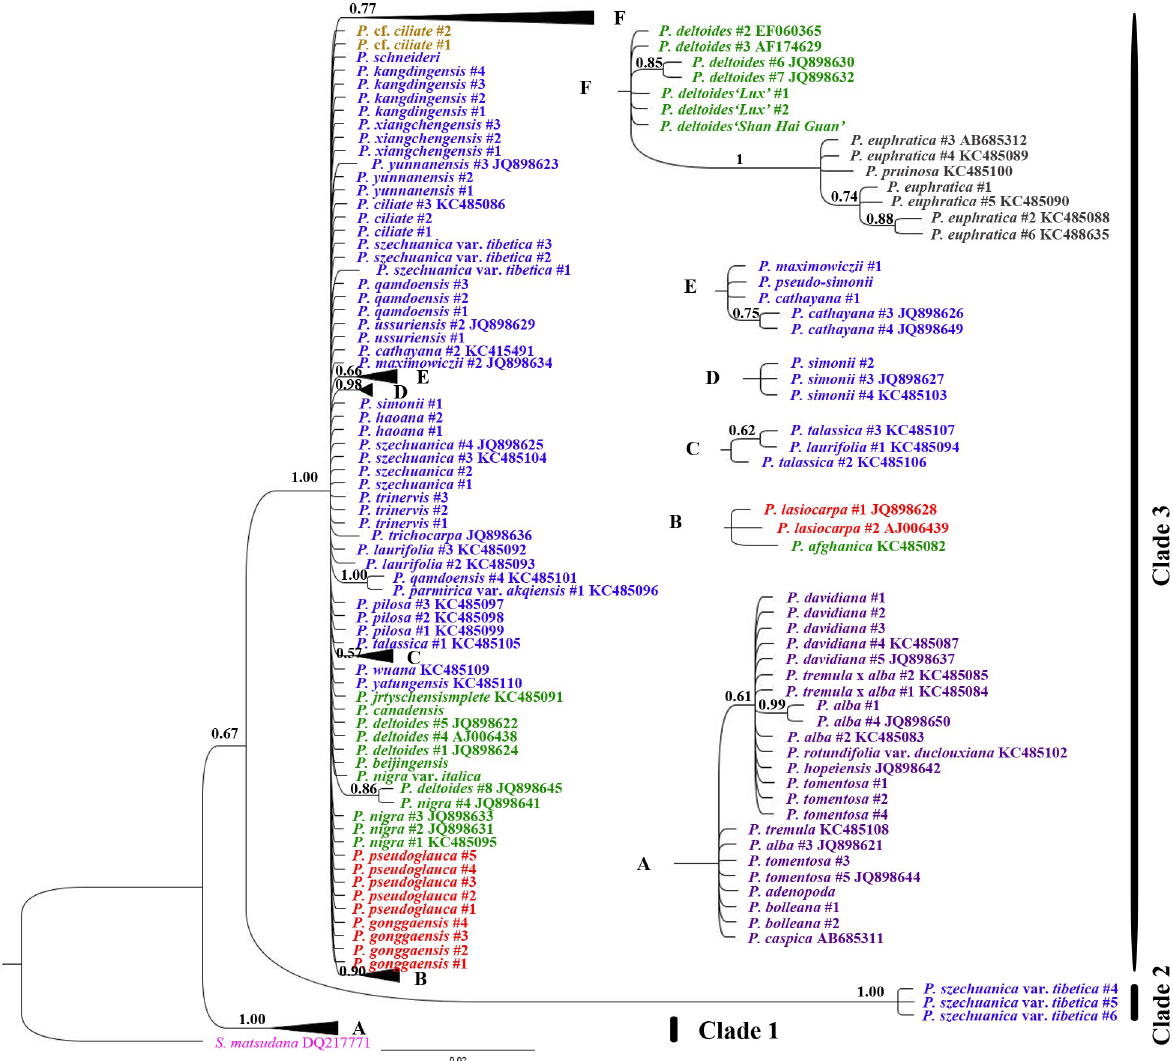
Fig 6. Bayes phylogenetic tree based on ITS regions. The TVM+I+G model for appropriate nucleotide substitution was constructed using Modeltest 3.7 with the AIC. Bayesian posterior probability values are reported for nodes over 50%. The traditional species taxa, based on morphological characteristics, are shown in different colors. The outgroup is pink, Tacamahaca is blue, Aigeiros is green, Leuce is purple, Leucoides is red, Turanga is brown, and hybrids are yellow.